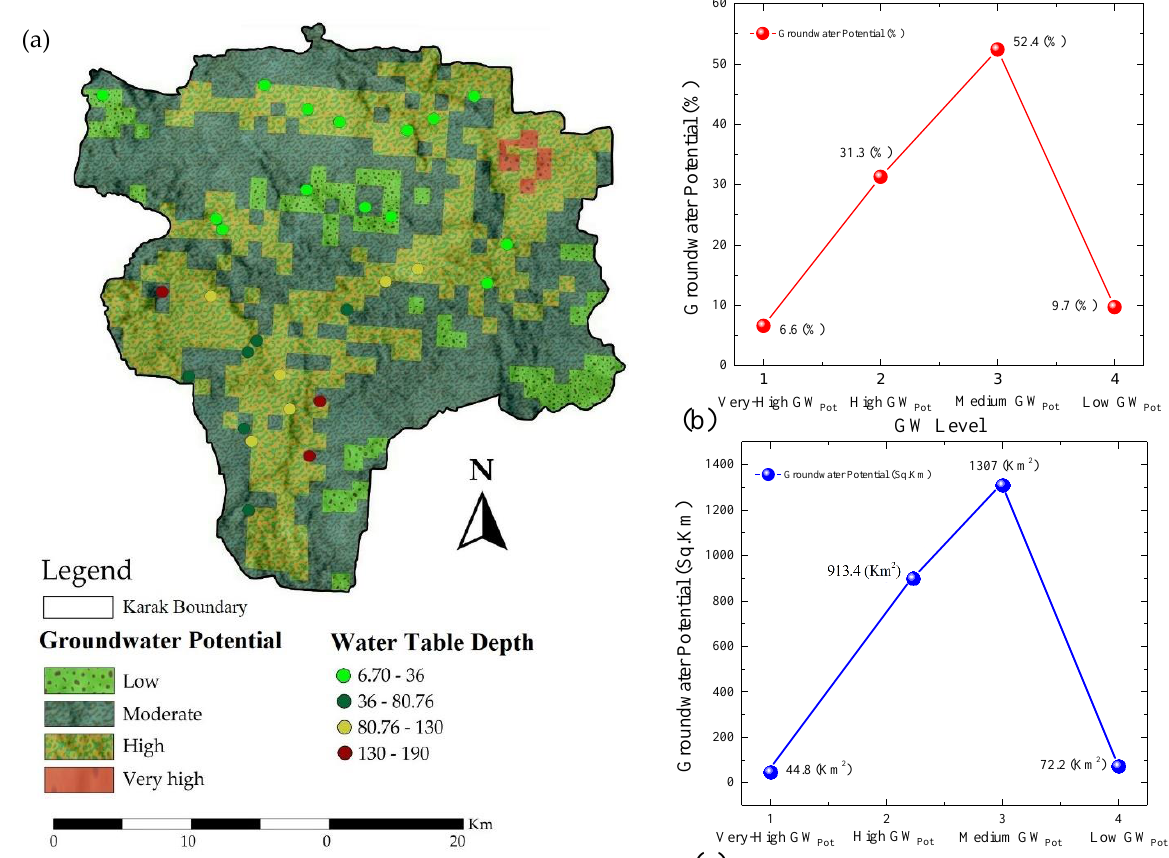
Figure 7. ( a ) GW pot zones and groundwater level depths of boreholes/wells; ( b ) groundwater potentiality in square kilometers and ( c ) in percentage of the Karak watershed.